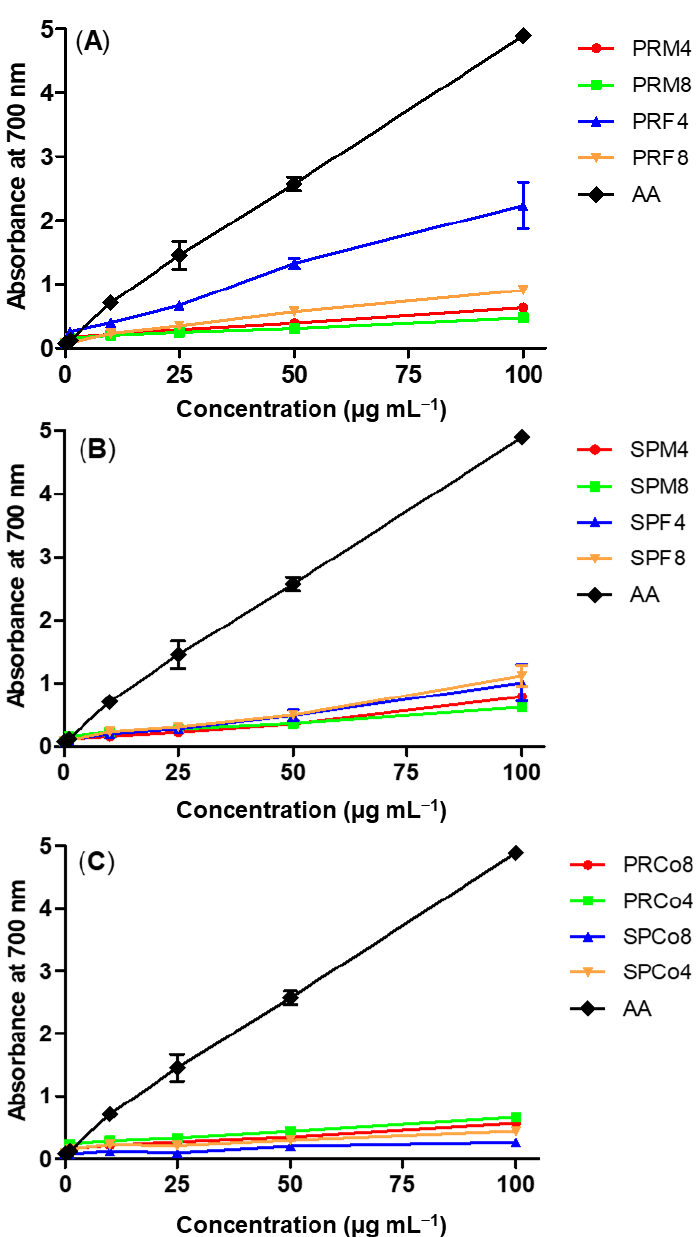
Figure 4. Reducing power assay of ethyl acetate fractions of ( A ) B. trimera and ( B ) B. myriocephala and ( C ) commercial samples from Paraná and São Paulo states. The data show mean ± standard deviation (SD) values as an average of 3 independent experiments performed in duplicate. Co = commercial samples, F = female specimens, M = male specimens SP = São Paulo state and PR = Paraná state. The presented numbers are related to the pH conditions used to obtain each fraction.